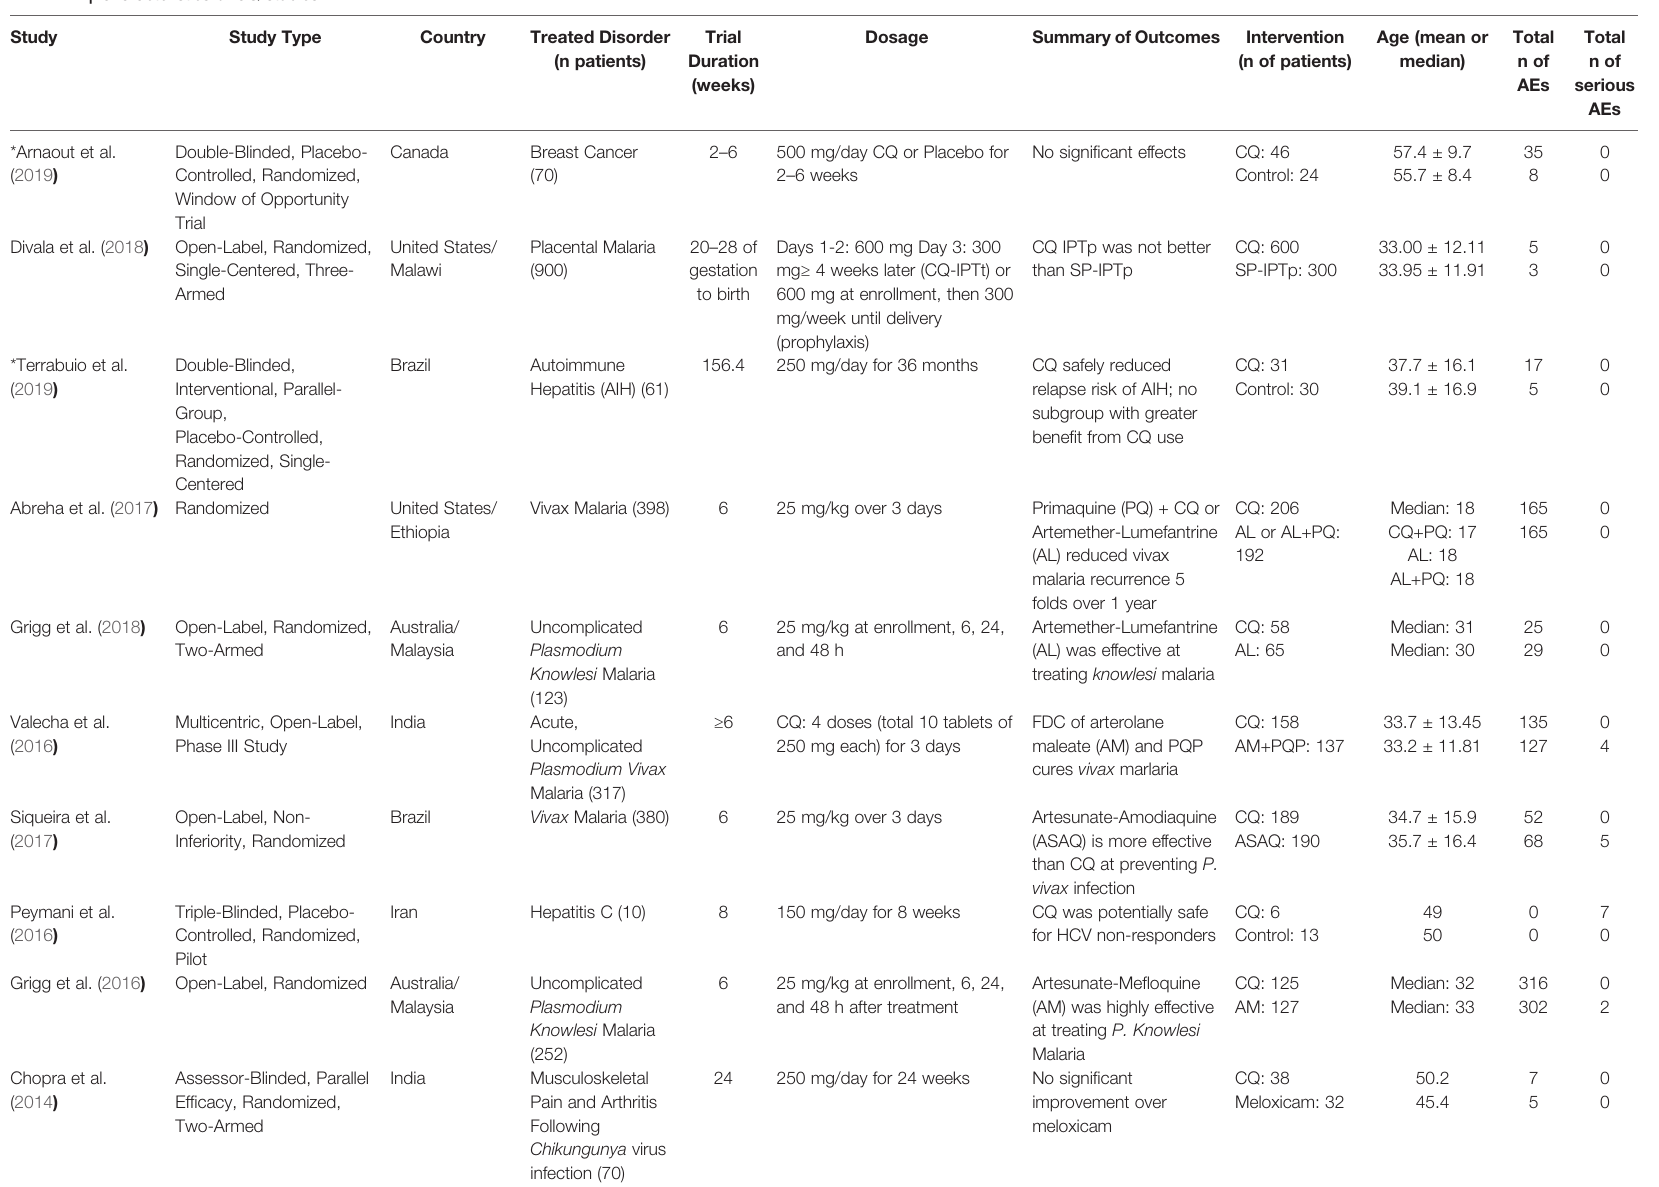
TABLE 1 | Characteristics of CQ